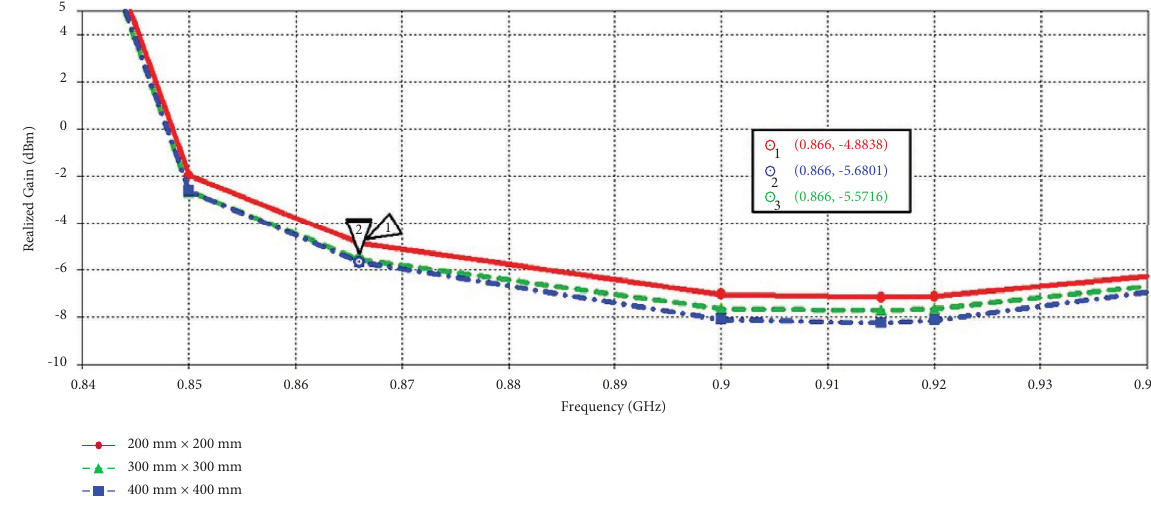
Figure 12: Gain performance of the tag with varying metal sheet size. Table 1: Optimized dimensions of the proposed